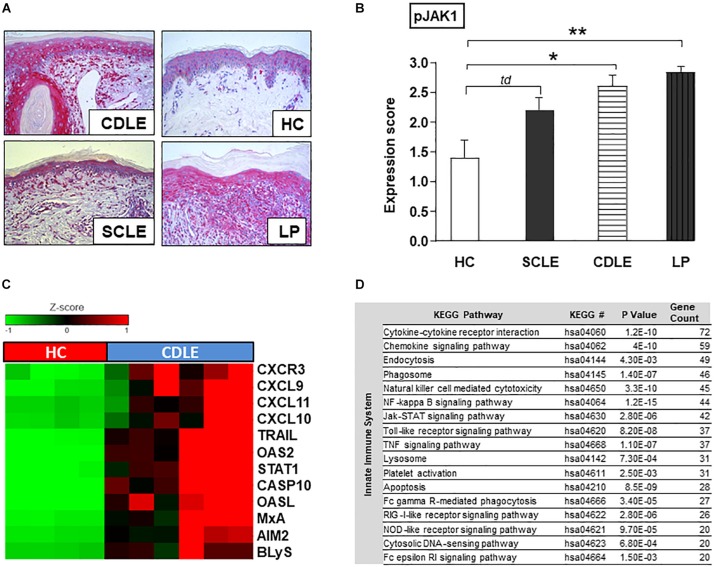
Functional role of JAK1 expression in CLE skin lesions. (A) Representative immunohistochemical sections (anti-phospho JAK1 staining) from skin samples of patients with different inflammatory skin disorders [Subacute cutaneous lupus erythematosus (SCLE, n = 5), chronic discoid lupus erythematosus (CDLE, n = 5), Lichen planus (LP, n = 6), and healthy controls (HC, n = 5)], original magnification ×200. (B) The expression of pJAK1 was scored semi-quantitatively by scoring from 0 =̂ no expression to 3 =̂ strong expression (18). All bars show mean ± SEM, td =̂ p < 0.1, * =̂ p < 0.05, ** =̂ p < 0.01 (Kruskal-Wallis-Test). (C) Upregulated expression of IFN-associated genes in CLE lesional skin (twofold, p < 0.01; Welch’s t-test) compared to healthy controls (HC). (D) KEGG pathways upregulated in CLE. KEGG pathway classification was performed using Database for Annotation, Visualization and Integrated Discovery (DAVID version 6.8). P-values were generated with EASE Score. Count: number of genes >twofold upregulated in CLE within the respective KEGG pathway.